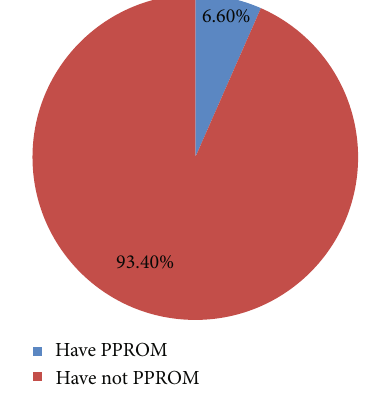
Figure 1: Prevalence of preterm premature rupture of membrane among pregnant women admitted in Wolkite comprehensive specialized hospital, Gurage zone, southern Ethiopia,